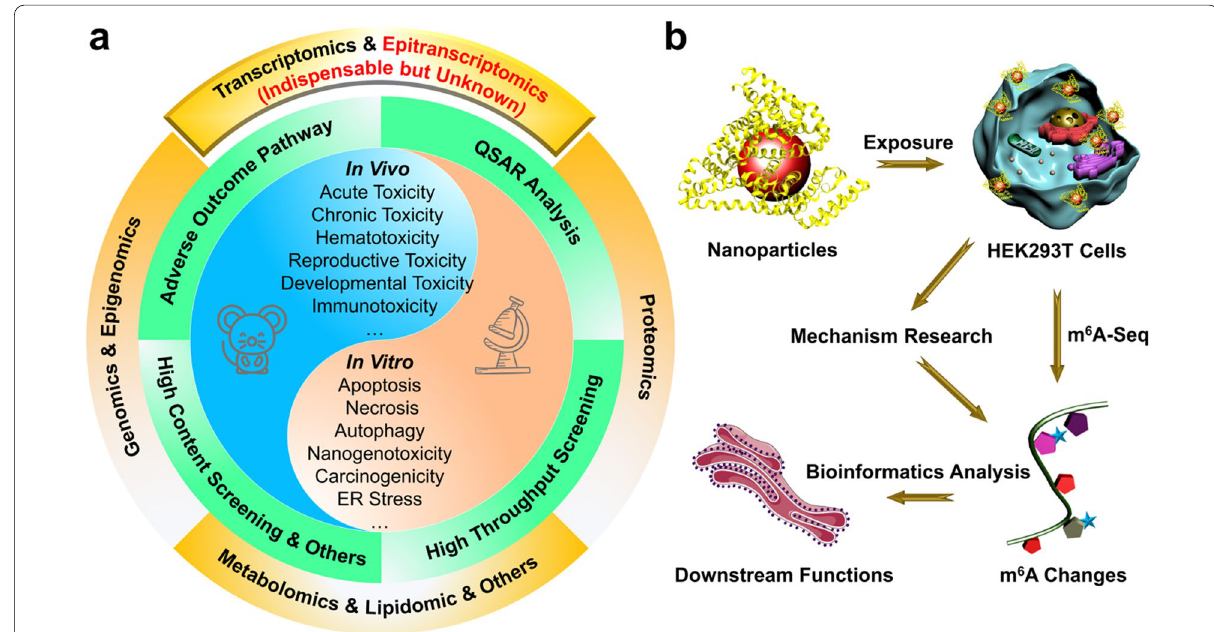
Fig. 1 Global view of nanotoxicology. a Illustration of current nanotoxicity evaluation frameworks (QSAR: quantitative structure–activity relationship). b Schematic diagram of the epitranscriptomic nanotoxicity evaluation of BSA-templated